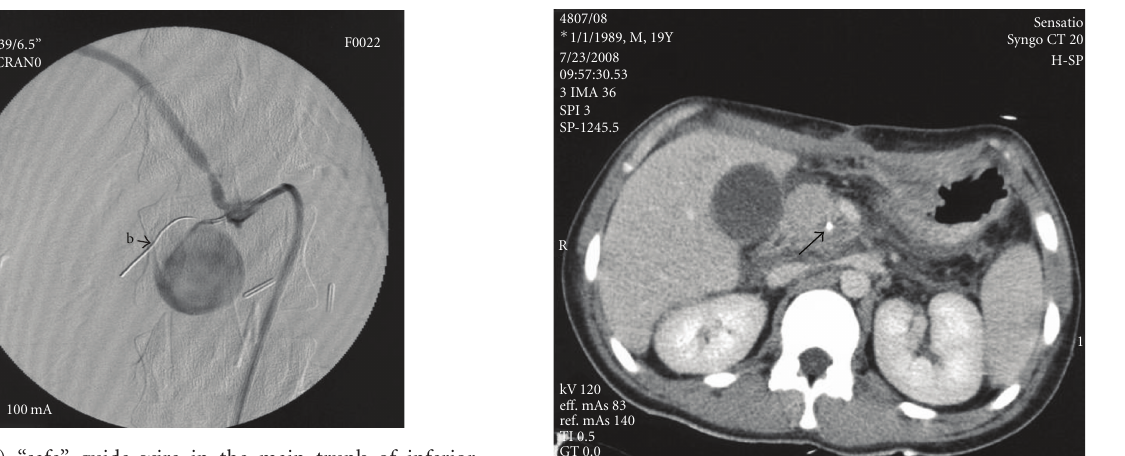
Figure 5: (b) “safe” guide wire in the main trunk of inferior pancreaticoduodenal artery, visualisation of replaced right hepatic artery, and filling of pseudoaneurysm.